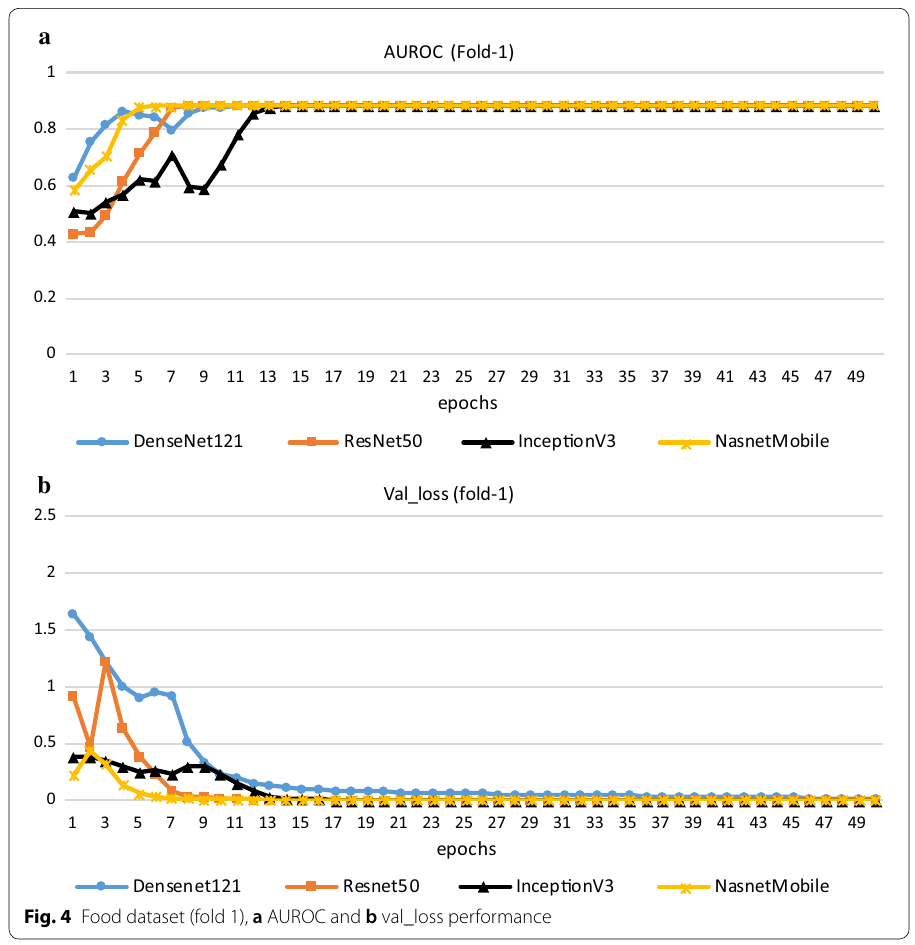
Fig. 4 Food dataset (fold 1), a AUROC and b val_loss